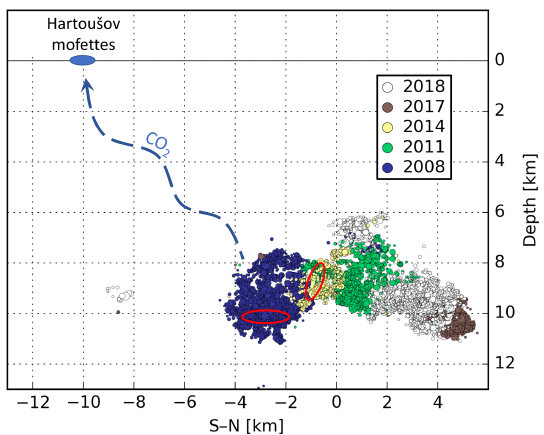
Figure 9. Vertical, north–south-oriented section through the Nový Kostel fault zone with hypocenters of the earthquake swarms oc- curred between 2008 and 2018. The position of the Hartoušov mofette showing coseismic CO 2 flow rate increase is indicated on the surface. Red ovals show the position of first events of the 2008 and 2014 seismic